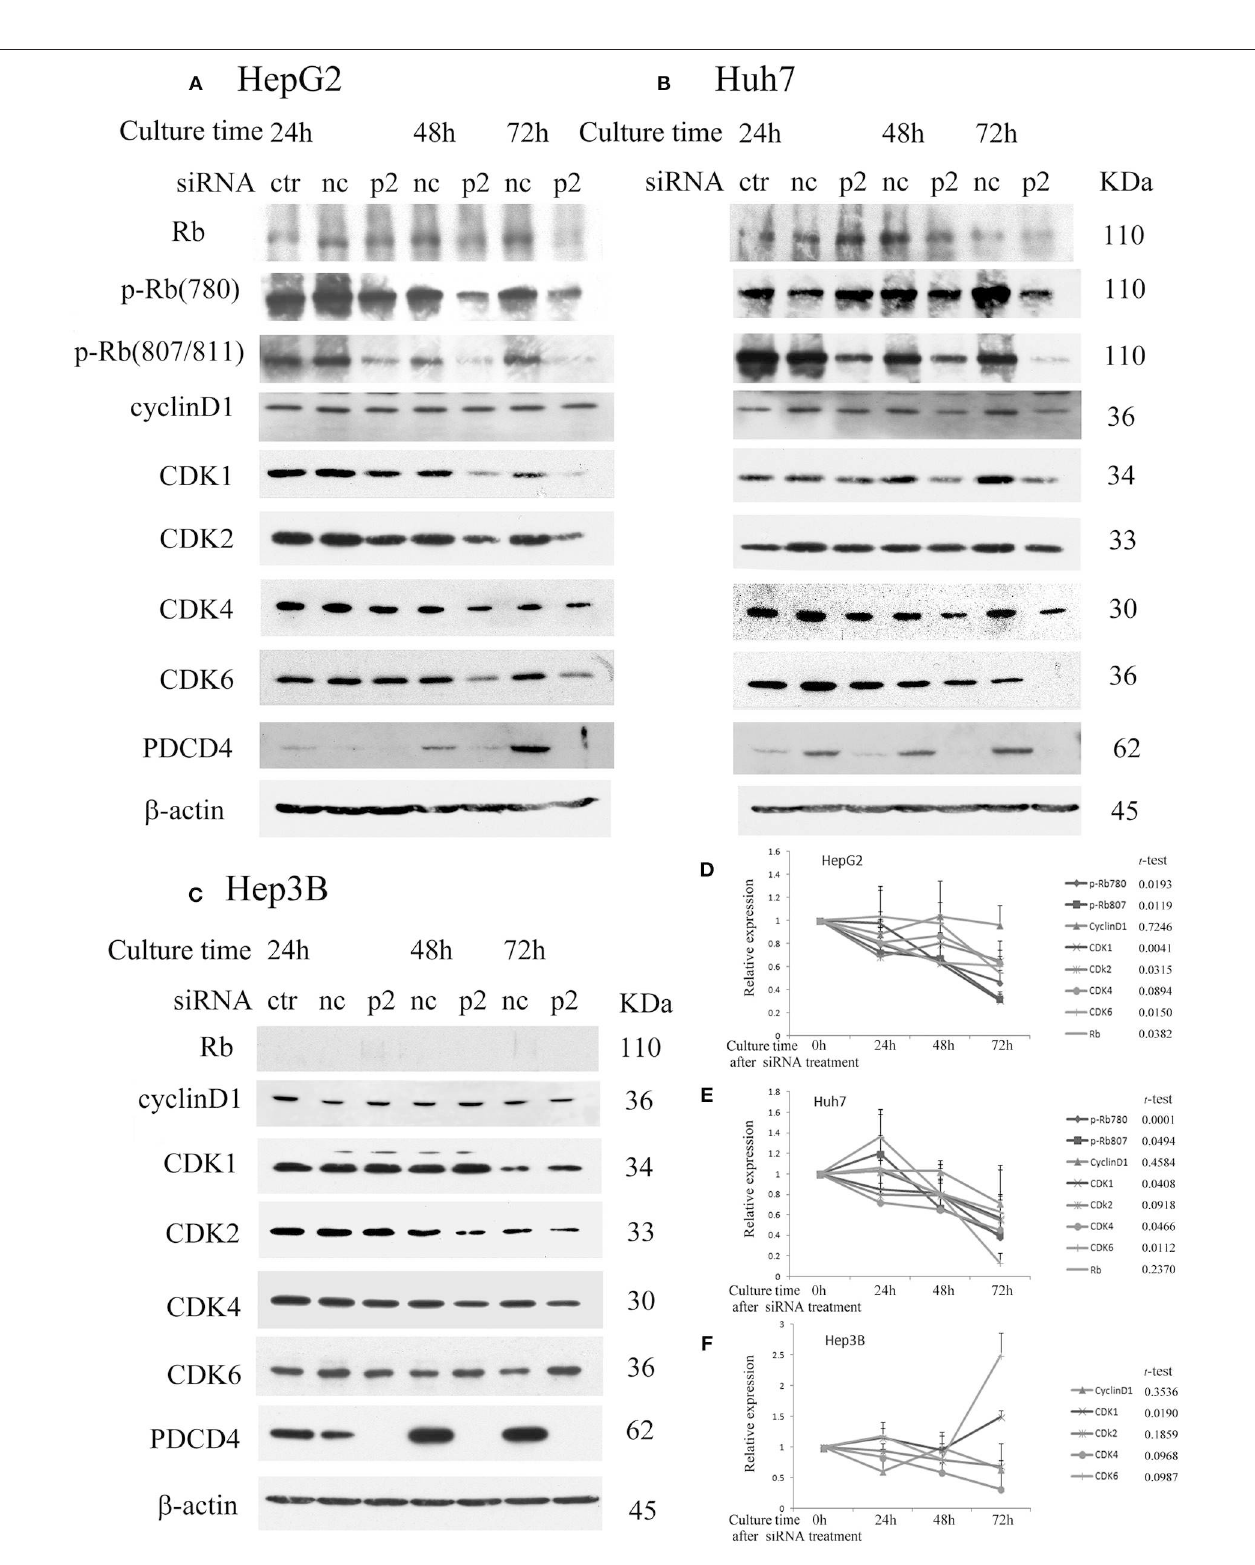
FIGURE 2 | PDCD4 knockdown suppressed Rb and p-Rb and modulated the expression of CDKs. PDCD4 knockdown suppressed the expression of Rb, CDK1, CDK2, CDK4, CDK6, and Rb phosphorylation in (A) HepG2 (wild-type p53) and (B) Huh7 (mutant p53 and p16-deficient). (C) The expression of CDK1 significantly up-regulated while the modulations of CDK2, CDK4, and CDK6 were not significant in Hep3B (p53- and Rb-deficient) cells. Protein extracts from untreated control